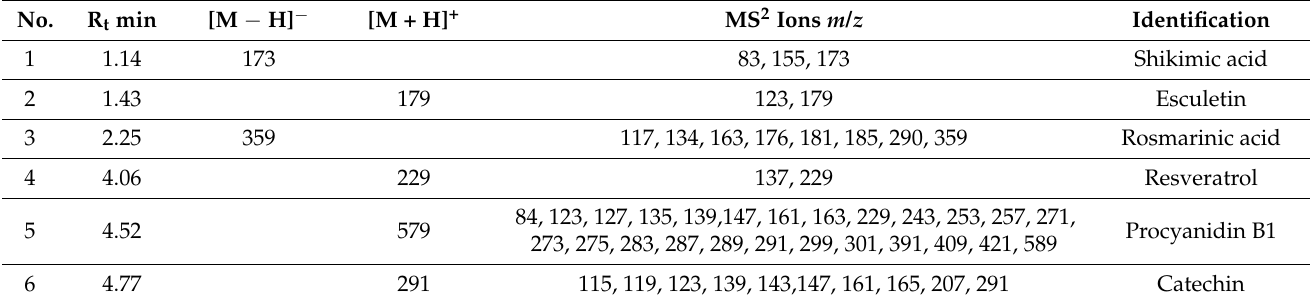
Table 1. Phytochemical profiling of A . pilosa by LC-ESI-MS/MS in negative and positive mode.